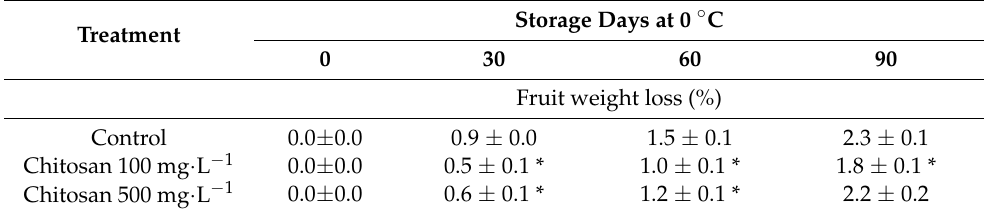
Table 2. Effects of preharvest chitosan application on fruit weight loss in ‘Garmrok’ kiwifruit during cold storage. Experimental data represent means ± standard error with n = 10. * in each column indicate significant differences between treatments at each sampling date, according to the least significant difference (LSD) test at p ≤